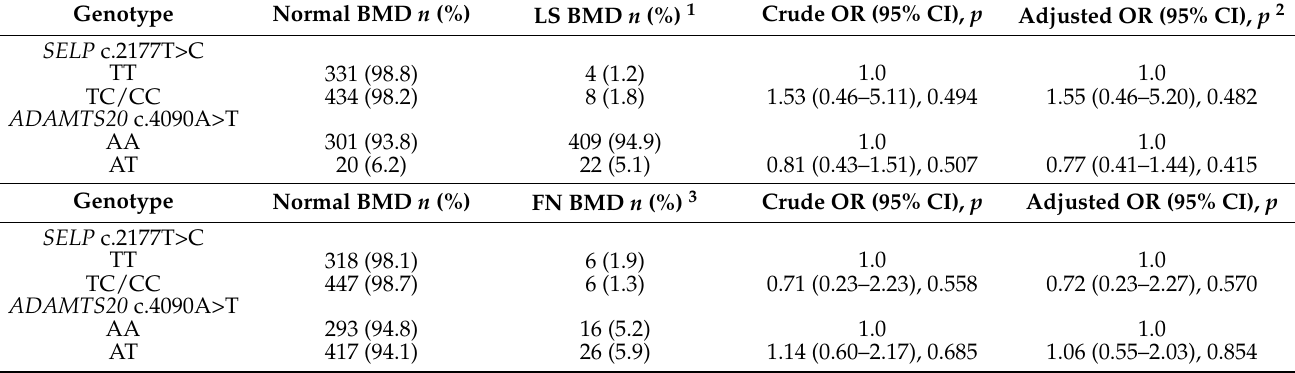
Table 6. Crude and Adjusted ORs with 95% CI for BMD and fracture risk. Logistic regression